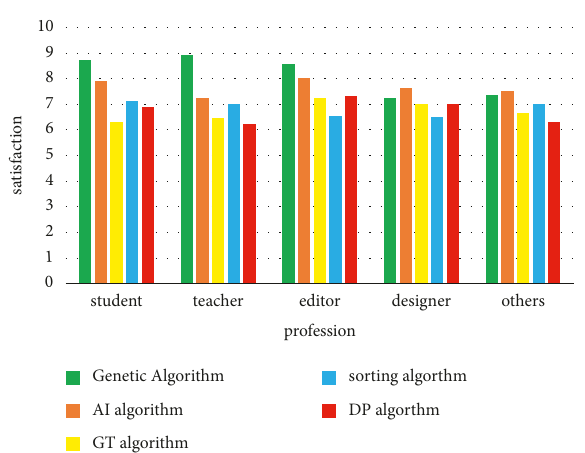
Figure 9: User satisfaction test